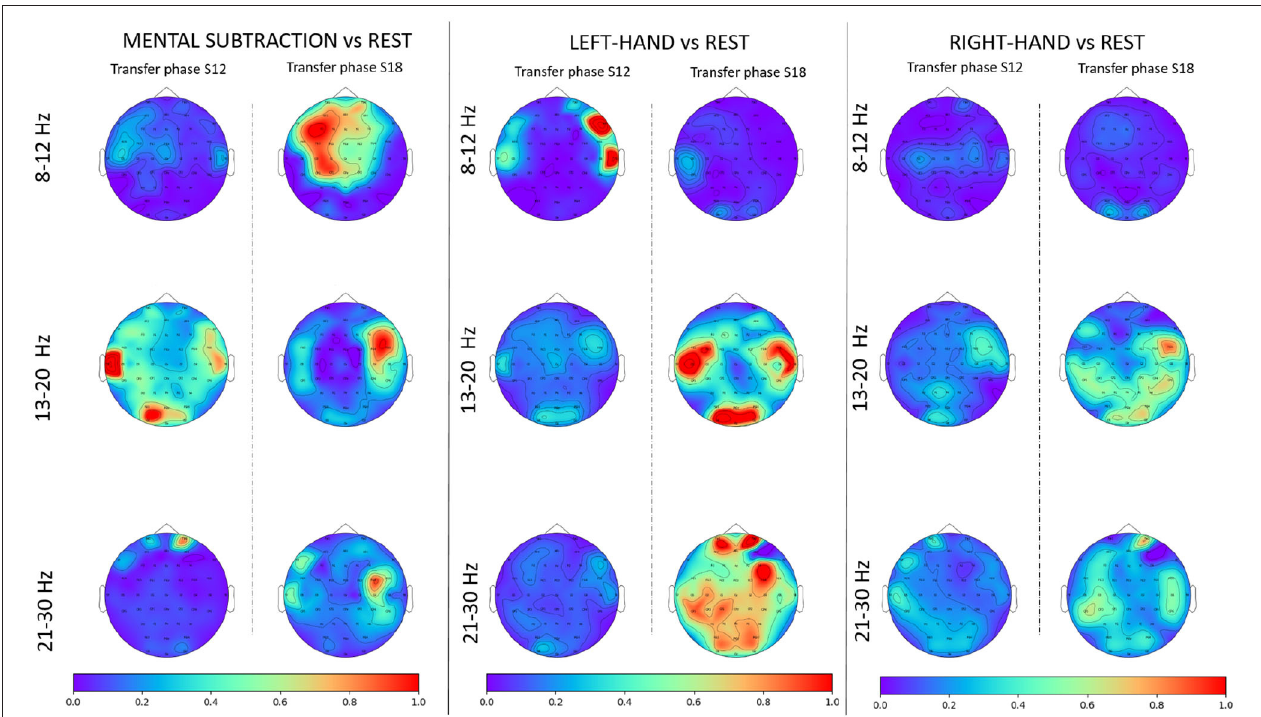
FIGURE 12 | Topographic maps (Fisher Score) for each frequency band for the 3 active classes against rest state. For each condition, we compared the mean FS over the runs of the first session of the transfer phase and the one of the last session of the same phase.